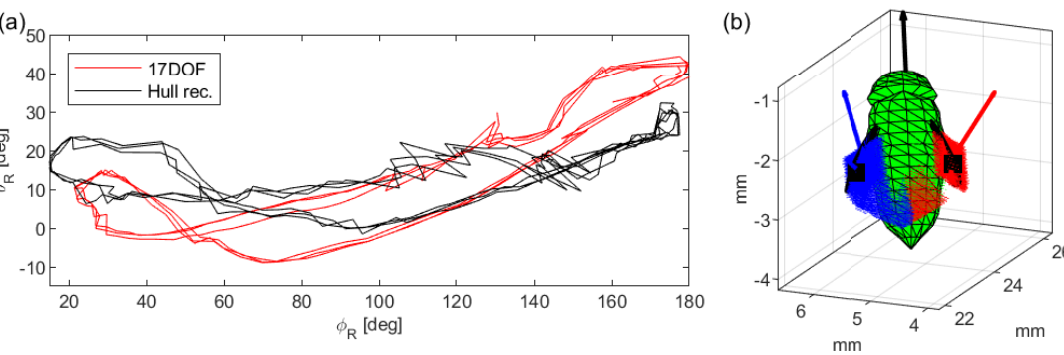
Figure A2. Comparing the 17-DOF model to hull reconstruction tracking in the current camera configuration. The unperturbed flight video from Figure 9 was analyzed using a hull reconstruction algorithm which approximates the performance of the methods reported in [13,14] by adjusting the latter method to the current camera configuration, higher resolution and higher frame rate. ( a ) The elevation angle of the right wing θ R as a function of the stroke angle of the same wing φ R . Results of the 17-DOF model (red) are less noisy and more self-consistent than the results of the hull reconstruction method, especially when the wings are at the back ( φ R = 130 − 180 ◦ ). ( b ) The reconstructed hull and the fitted 17-DOF model, both superimposed. In this video frame, when the wings are at the back, wing–wing and body–wing occlusions result in a oversized wing hull, which causes errors in the wing pose estimation. For example, both chord vectors are wrongly identified by the hull reconstruction method (red and blue line). In this example, the wings’ DOFs are correctly identified by the 17-DOF